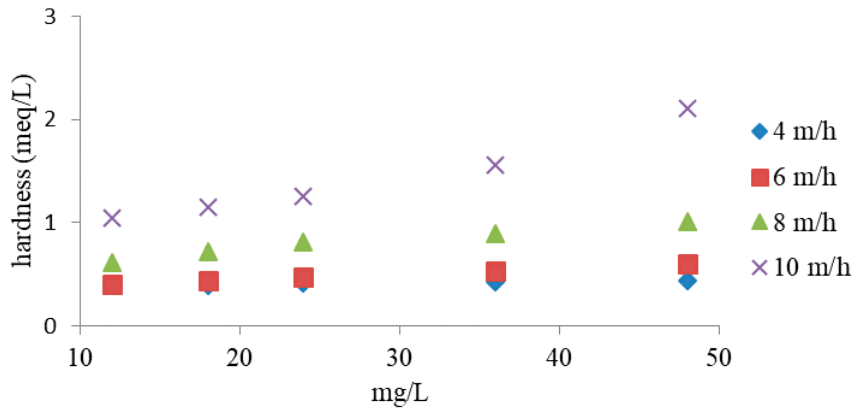
Figure 12. Relationship between initial ammonia concentration, hardness degree, and flow rate.